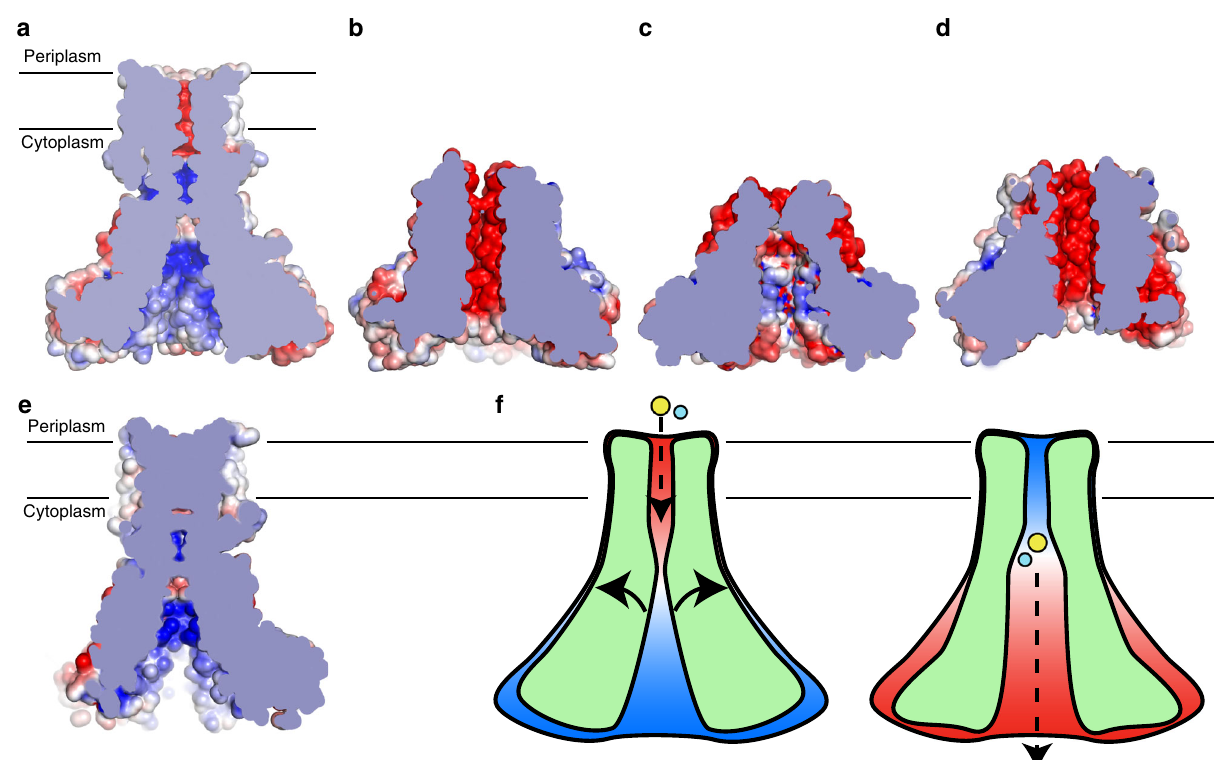
Fig. 5 Possible mechanism of Zn 2+ transport by ZntB. a Calculated electrostatic potential ( ± 5 kT e − 1 ) of ZntB (cross-section of the pore is shown) ( b ) same for Zn 2+ -bound soluble domain of StZntB and ( c ) Zn 2+ -free soluble domain of VpZntB. d Phyre2-based model of putative Zn 2+ -bound EcZntB using StZntB as a template (pdb id 3NWI). e Phyre2-based model of full-length apo StZntB using EcZntB as a template. f Putative mechanism of Zn 2+ transport via ZntB. ZntB cross-section is shown schematically; Zn 2+ and H + are shown as yellow and cyan spheres, respectively; arrows indicate possible movements of trans membrane helix 1, which are possibly caused by Zn 2+ and/or H + binding, eventually leading to the change in electrostatic potential (from positive (blue) to negative (red)) within the pore that stimulates ion advancement through